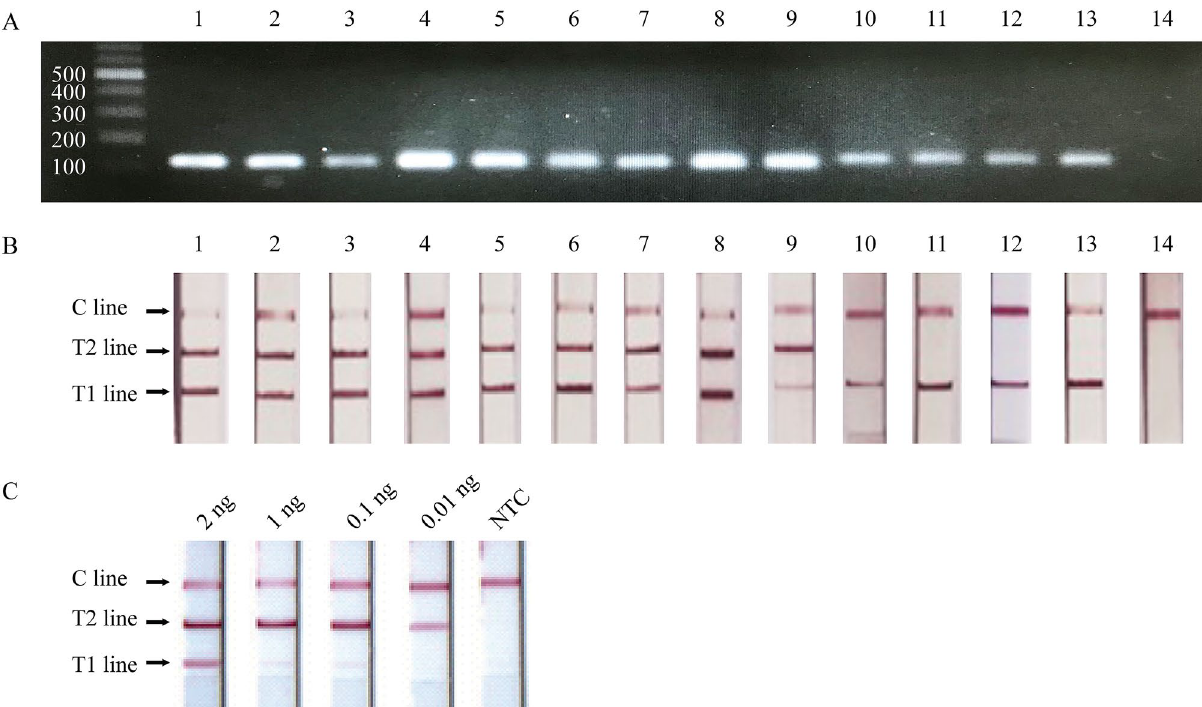
Figure 5. Specificity and sensitivity of the PCR - LFA for the detection of PCR amplicons generated with a set of primers, A397F, C357F and R502. ( A ) Image of PCR amplicons as detected by 1.7% agarose gel electrophoresis. 1 : A. pierrei , 2 : A. pothieri , 3 : A. acuminata , 4 : A. gigantea. 5 : A. grandiflora , 6 : A. cambodiana , 7 : A. littoralis, 8 : A. ringens , 9 : A. tentaculata , 10 : C. pulchellum , 11 : T. scabra , 12 : J. sambac , 13 : J. adenophyllum , 14 : no-DNA template as a control reaction. ( B ) T2 line was detected from Aristolochia spp. samples (1–9) but not detected from non- Aristolochia samples (10–14). ( C ) Sensitivity of the Aristolochia PCR - LFA. Template DNA: 2, 1, 0.1 and 0.01 ng. NTC : no-DNA